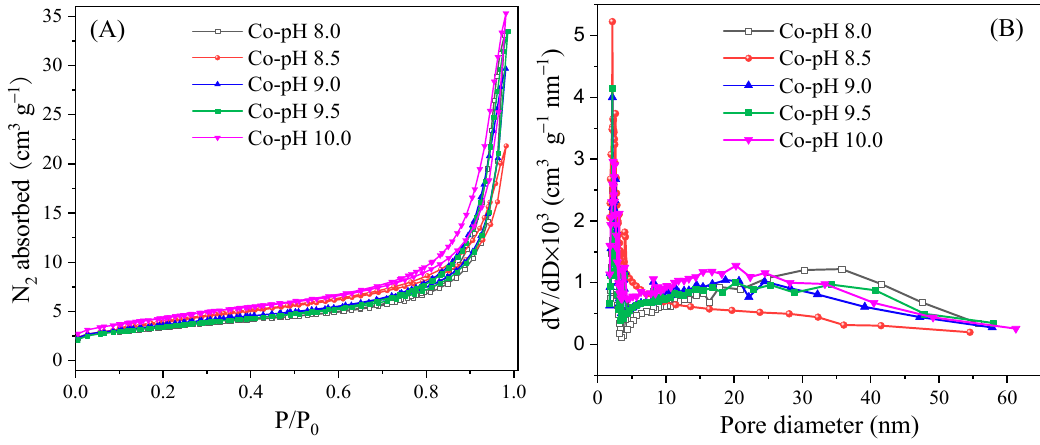
Figure 4. ( A ) N 2 adsorption − desorption isotherms and ( B ) pore size distributions of cobalt oxides prepared at different pH values.